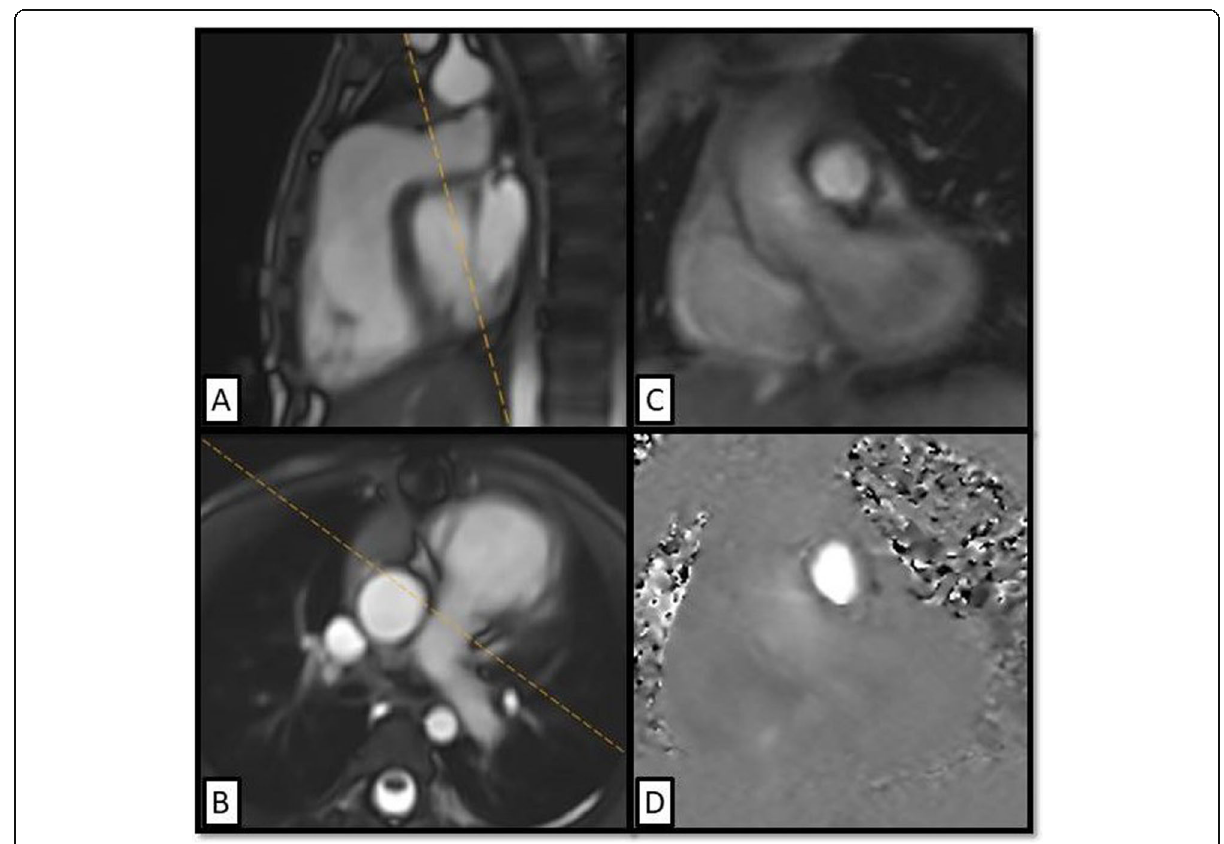
Fig. 1 Planning of 2D-PC flow across the MPA. ( a , b ) Two orthogonal planes taken on sagittal ( a ) and coronal ( b ) SSFP Cine images of the MPA. c The resultant anatomy magnitude cross section image of the MPA and d is the PC image showing the forward systolic flow across the MPA (white color). PC: phase contrast, CMR: cardiac magnetic resonance, MPA: main pulmonary artery, SSFP: steady-state free precession